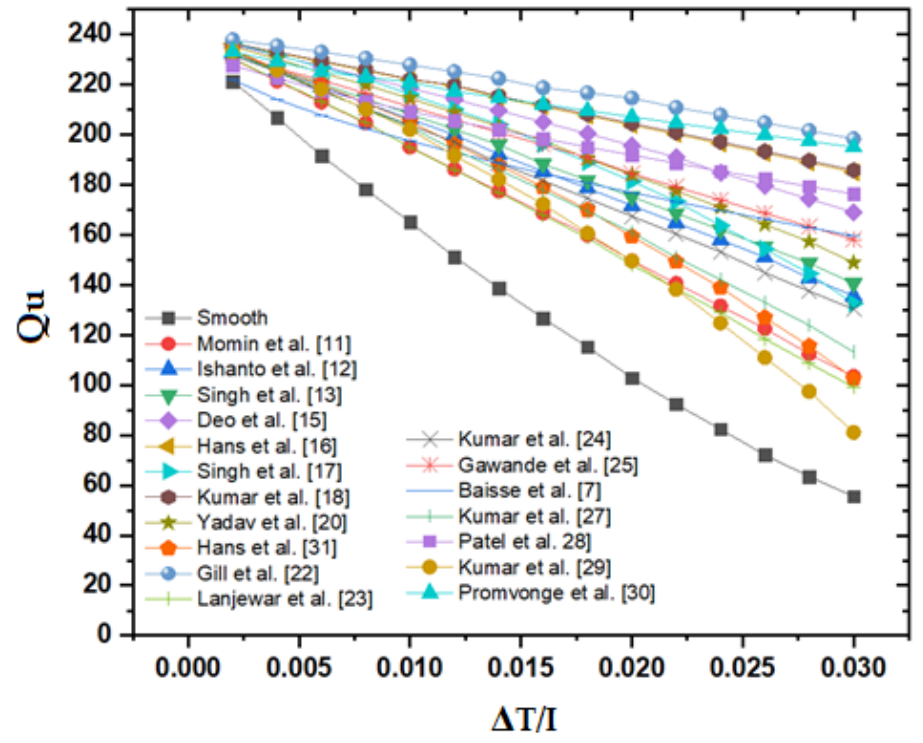
Figure 5. Useful heat gain of the roughened duct with respect to Δ T/I. The staggered broken arc hybrid-rib roughness shows consistently higher values of useful heat gain among distinct roughness geometries for the ascending values of Δ T/I. The plot between pumping power requirement and Δ T/I in all cases is shown in Figure 6. The staggered broken arc hybrid-rib shows a slightly higher value of pumping power re- quirement among distinct roughness geometries for the ascending values of Δ T/I.